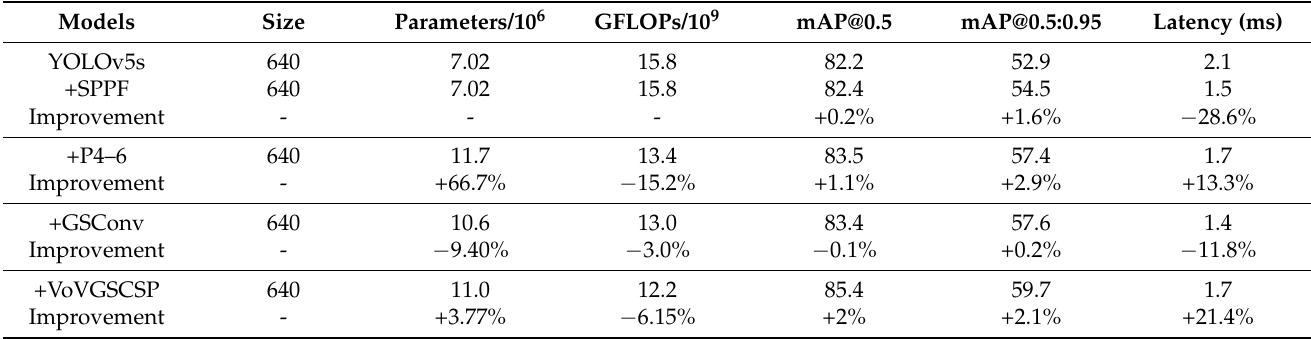
Table 4. Ablation